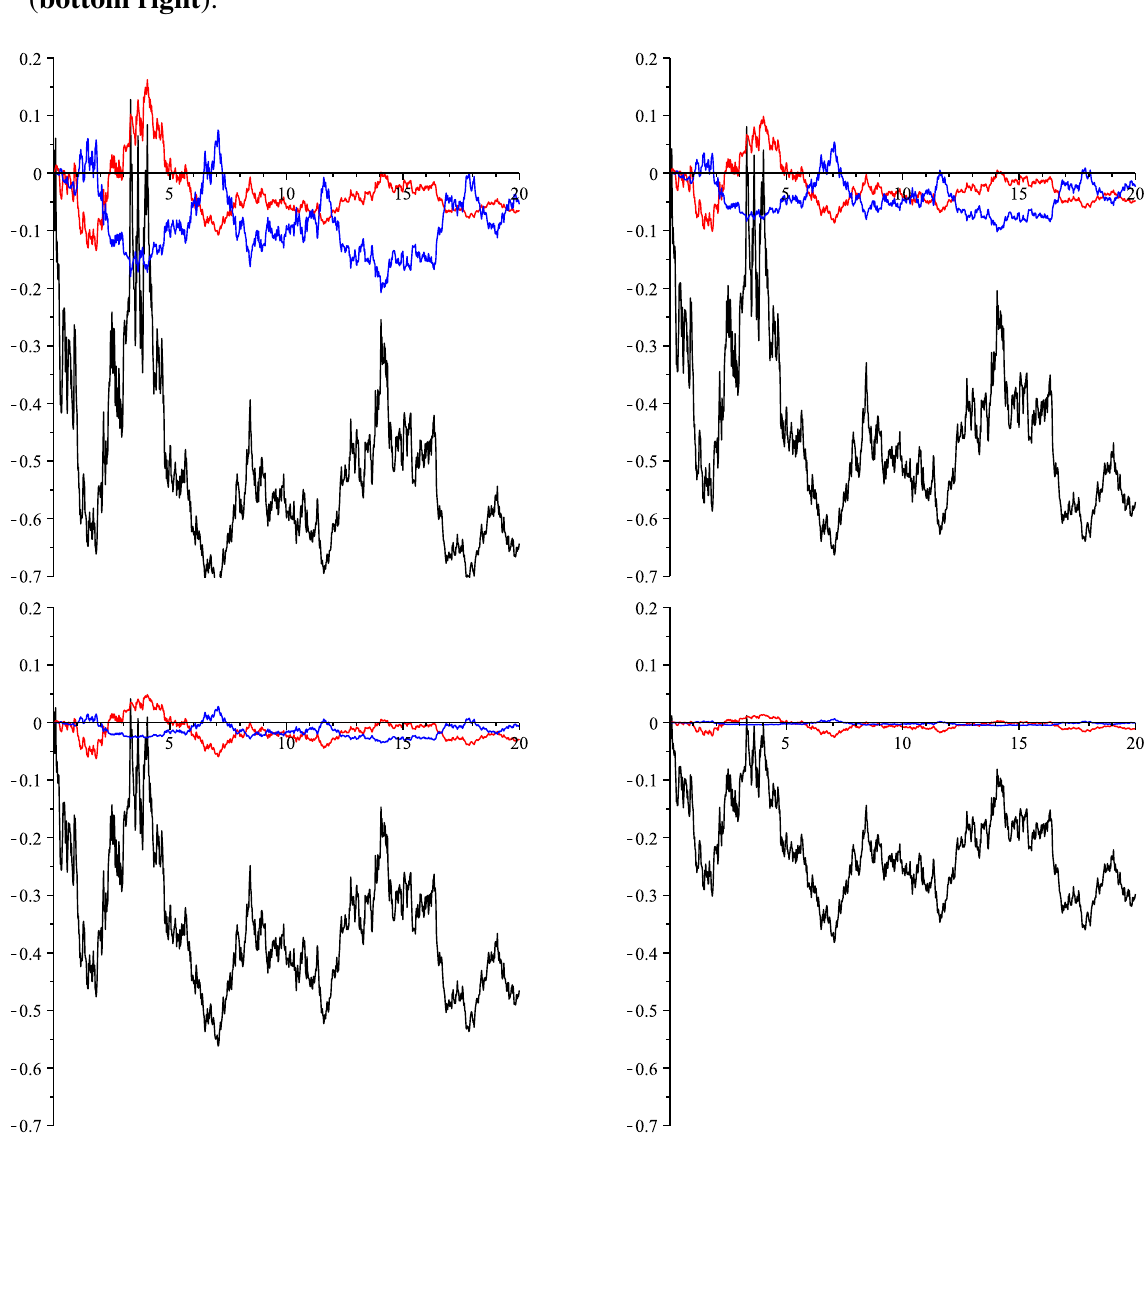
e b X ( t ) (red) and X ( t ) (blue) with respect